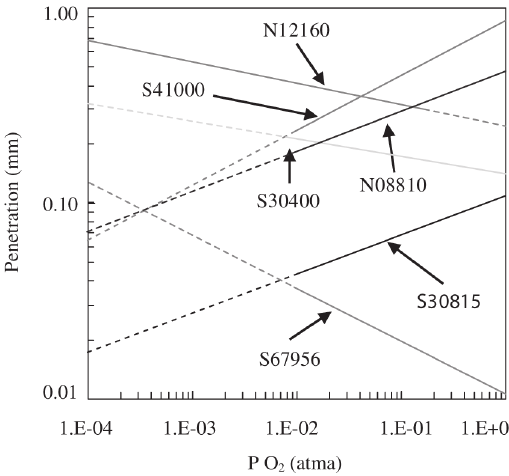
Figure 3. Effect of P O Upon Oxidation Corrosion of a Range of 2 Alloys at 900 °C After One